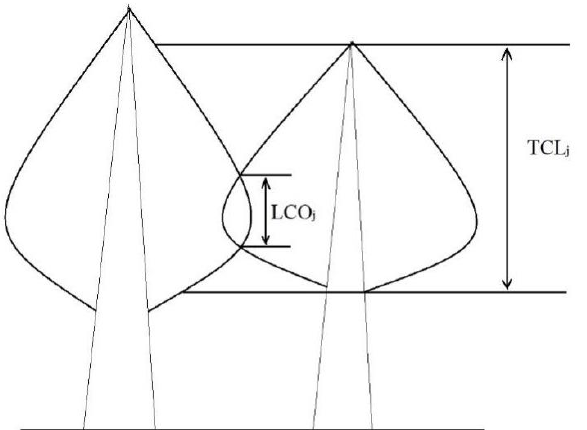
Figure 2. A graphical description for the calculation of the two competition indices (the CLI and the CLO) reflecting both horizontal and vertical competition. TCL j is the heights between the upper and lower contact points and LCO i is the vertical overlap length between the upper and lower contacting points between the sample and neighbor tree crowns.